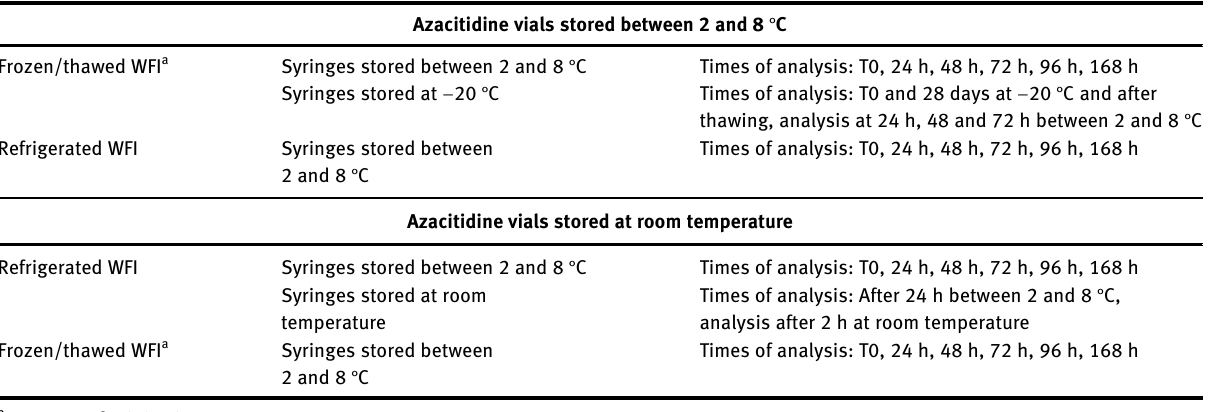
Table  : Conditions of analysis for the stability study of